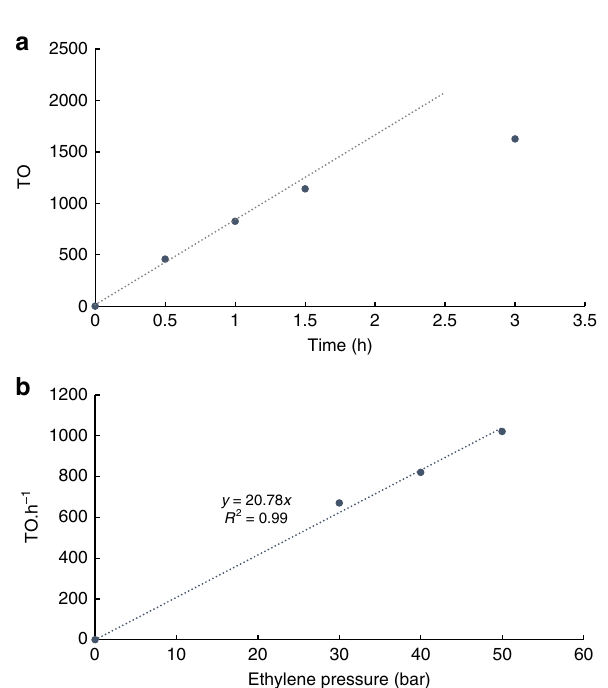
Fig. 4 Catalyst activity in micelles a ) Plot of TO over time (micelles formed with: 16 µ mol L 1 Pd-NR 3 , 430 mg PEG- b -PCF 3 , at 85 °C, 40 bar ethylene) Linear regression includes 0 h, 0.5 h and 1 h runs. b ) Plot of TO frequency at various ethylene pressures (micelles formed with: 16 µ mol L 1 Pd-NR 3 , 430 mg PEG-b-PCF 3 , at 85 °C, 1 h) showcasing that the catalyst ’ s rate